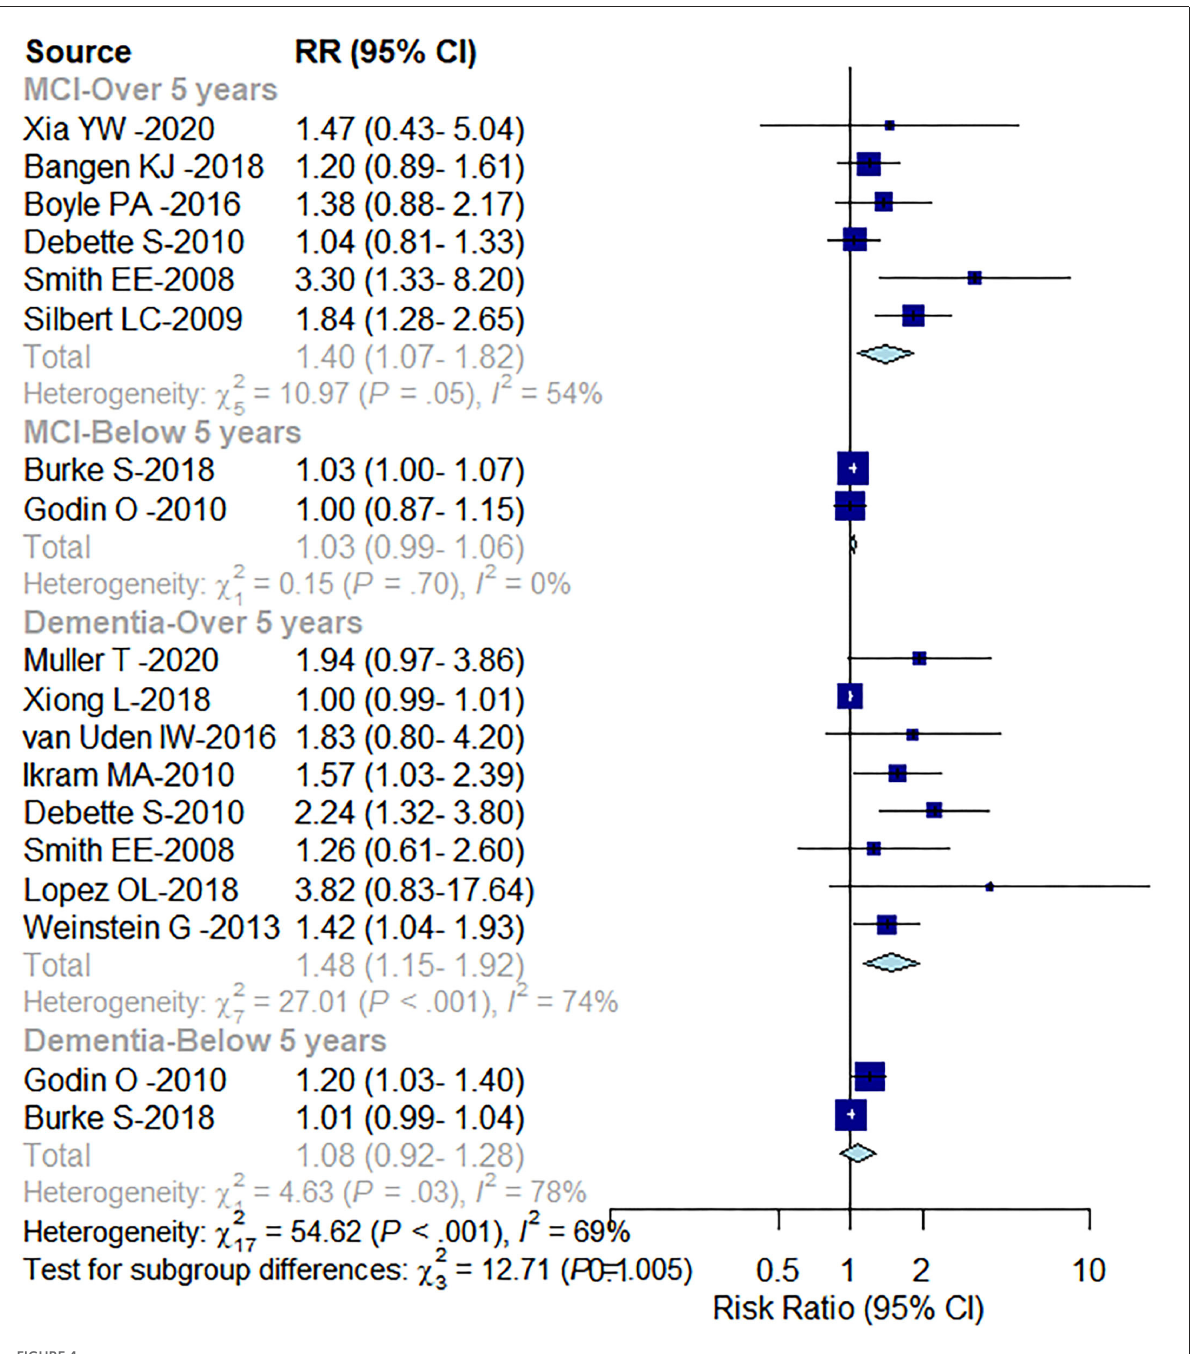
FIGURE4 Subgroup analysis based on follow-up